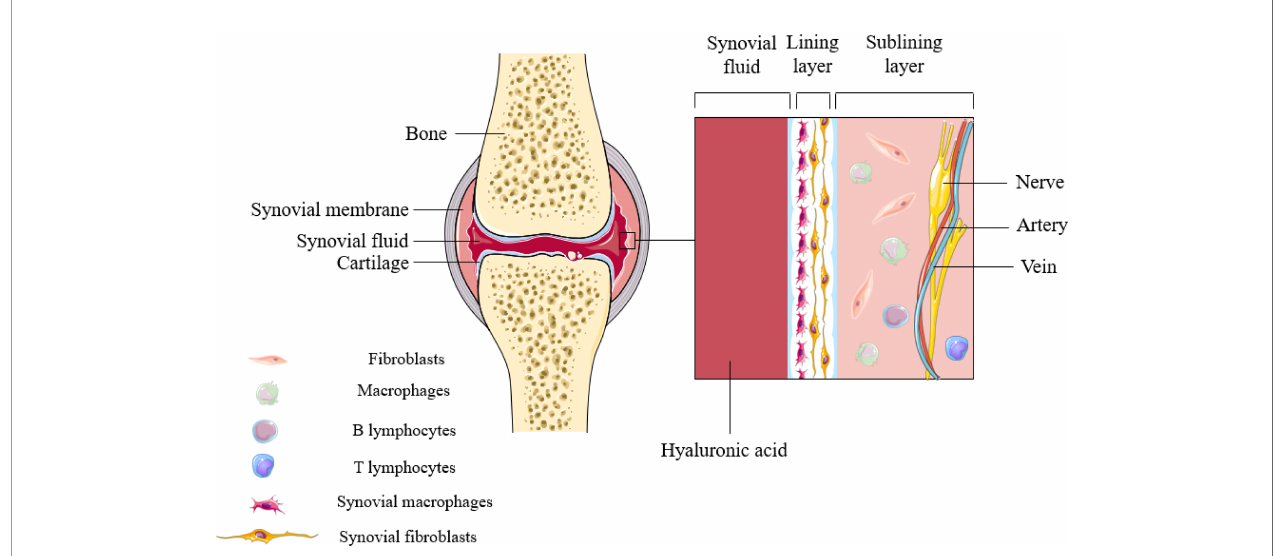
FIGURE 1 | Synovial structures in in fl ammatory arthritis. Synovial macrophages are mainly distributed in the lining layer of synovial tissue. During the onset of the disease, SMs can not only induce in fl ammation, but also perform immune